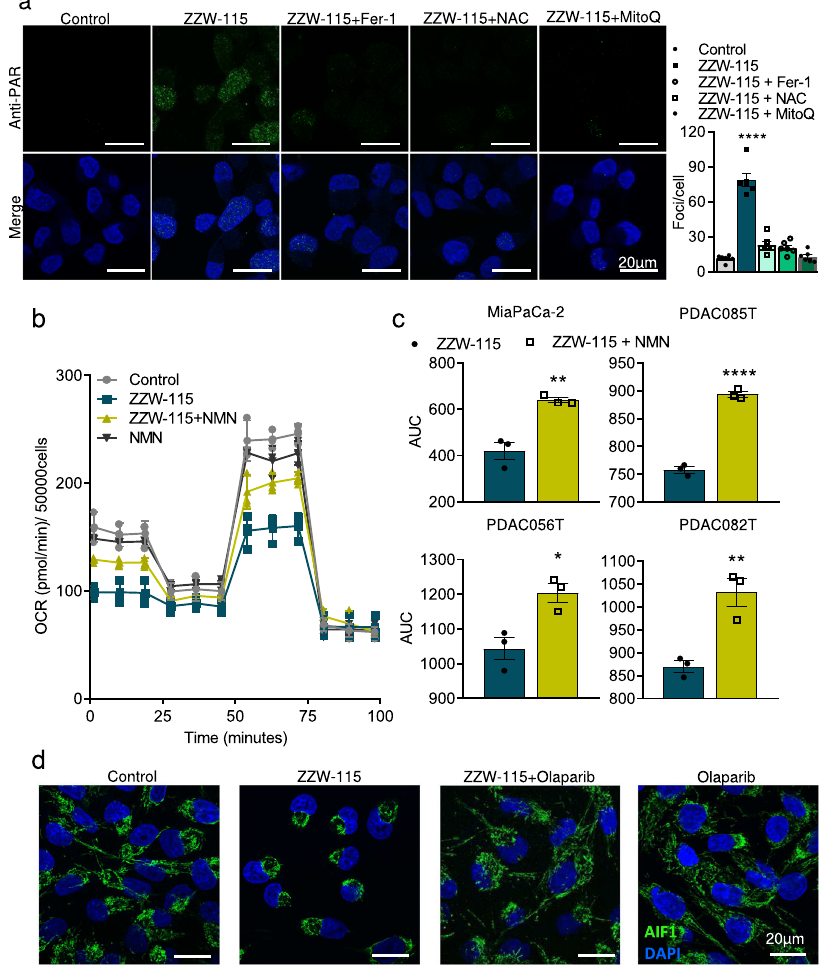
Fig. 5 ZZW-115-induced cell death is rescued by antioxidants and NMN but not promoted by AIF translocation. a MiaPaCa-2 cells were treated with ZZW-115 at 1.5 µ M in isolation or in the presence of Ferrostatin-1 (1 μ M), N-acetylcysteine (20 mM) or Mitoquinone (0.5 μ M) for 24 h. Mouse anti-PAR and Alexa 488-labeled goat anti-mouse secondary antibody were used. A representative experiment is shown ( n = 3). ImageJ was used to count the number of green dots ( n = 3). Data represent mean ± SEM. One-way ANOVA, Dunnett correction; * P < 0.05; ** P < 0.01; *** P < 0.001; **** P < 0.001. b OXPHOS metabolism, re fl ected by oxygen consumption rate (OCR) levels were measured in MiaPaCa-2 cells after 24 h treatment with ZZW-115 (1.5 µ M) and NMN (0.5 mM) ( n = 3). c Chemogram assays were done on 4 pancreatic cancer cell lines with increasing concentrations of ZZW-115 in